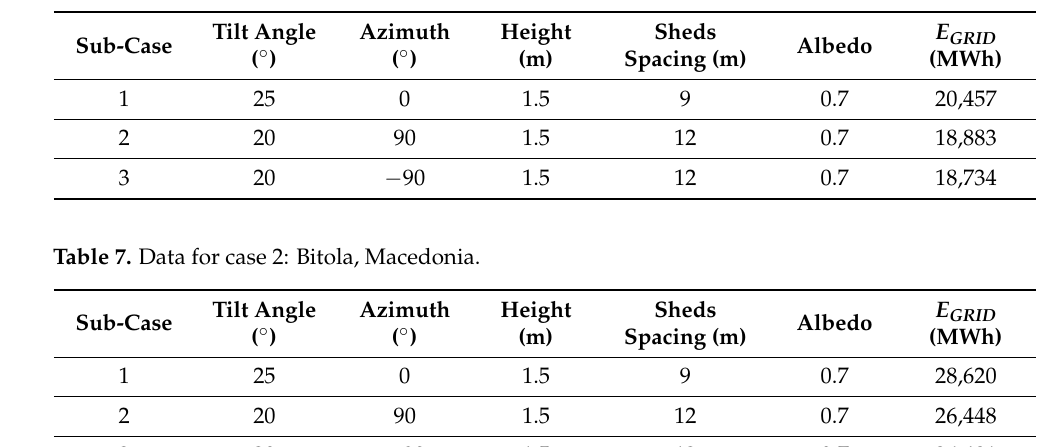
Table 6. Data for case 1: Gaag, Netherlands.